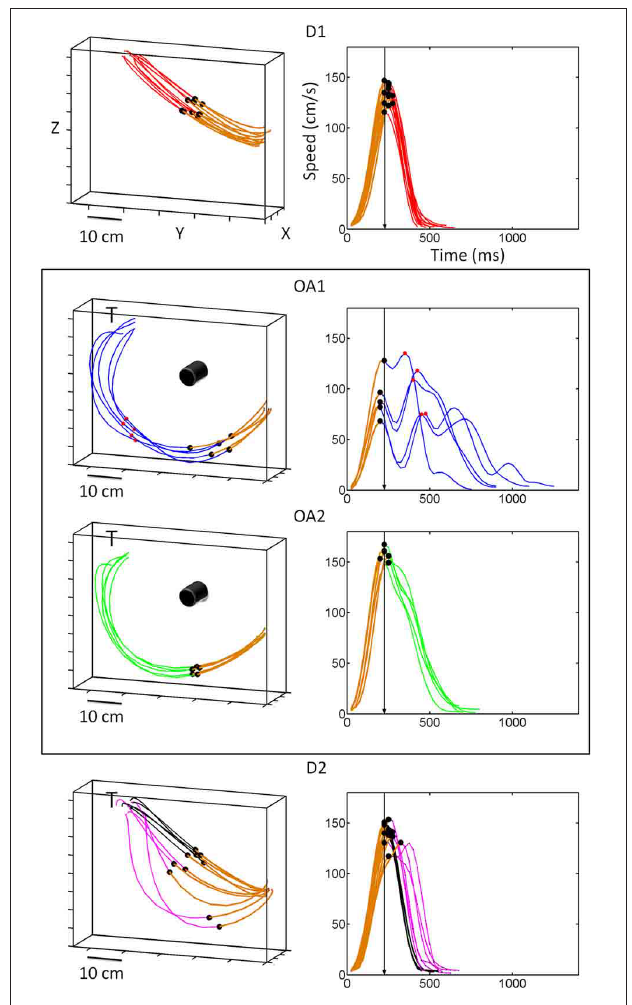
FIGURE 2 | Hand kinematics for movements to a single target, with and without an obstacle present. In the absence of an obstacle, handpaths (left panels) were straight and velocity profiles (right panels) were single peaked. The dots along the trajectory mark the first velocity peak of the trial. The first segment colored in brown marks the distance traveled up to the first velocity peak. This brown segment in the hand path corresponds to the acceleration phase of the reach, the initial portion of the speed profile, and the black dot on the speed profile is the first velocity peak also marked along the hand path. The other dots on the speed profile mark additional peaks along the path. The arrow in the speed profile marks the time to the first peak, which was the same across each target location despite differences in the distance traveled up to the first peak. The value of the first peak was adjusted by gradually varying the distance at a constant time. During OA1 and OA2, hand paths to this target became curved but were consistently smooth across trials and joints. In contrast, timing (in the deceleration phase) was highly variable in OA1 and only became consistent during OA2. During the first few trials of D2, an aftereffect of the obstacle was initially observed (pink traces), but movements rapidly reverted to the pattern of kinematics exhibited in